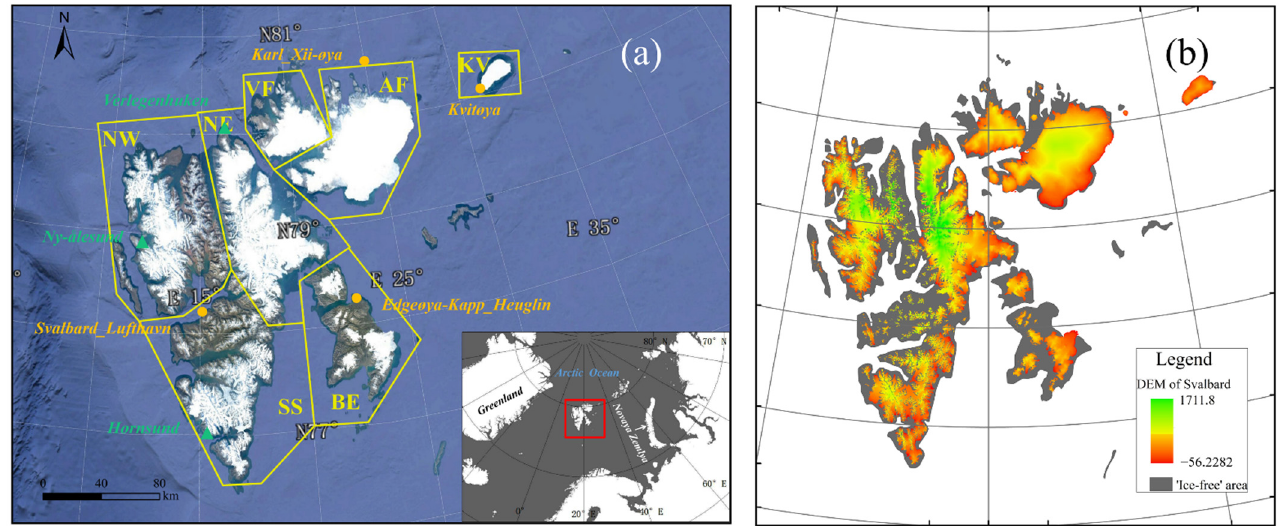
Figure 1. ( a )The location of Svalbard Archipelago and seven subregions division. The orange circle and the green triangle represent the location of the temperature weather station and temperature and precipitation meteorological station. ( b ) The DEM of Svalbard glaciers and the range of ‘ice-free’ area (grey region).